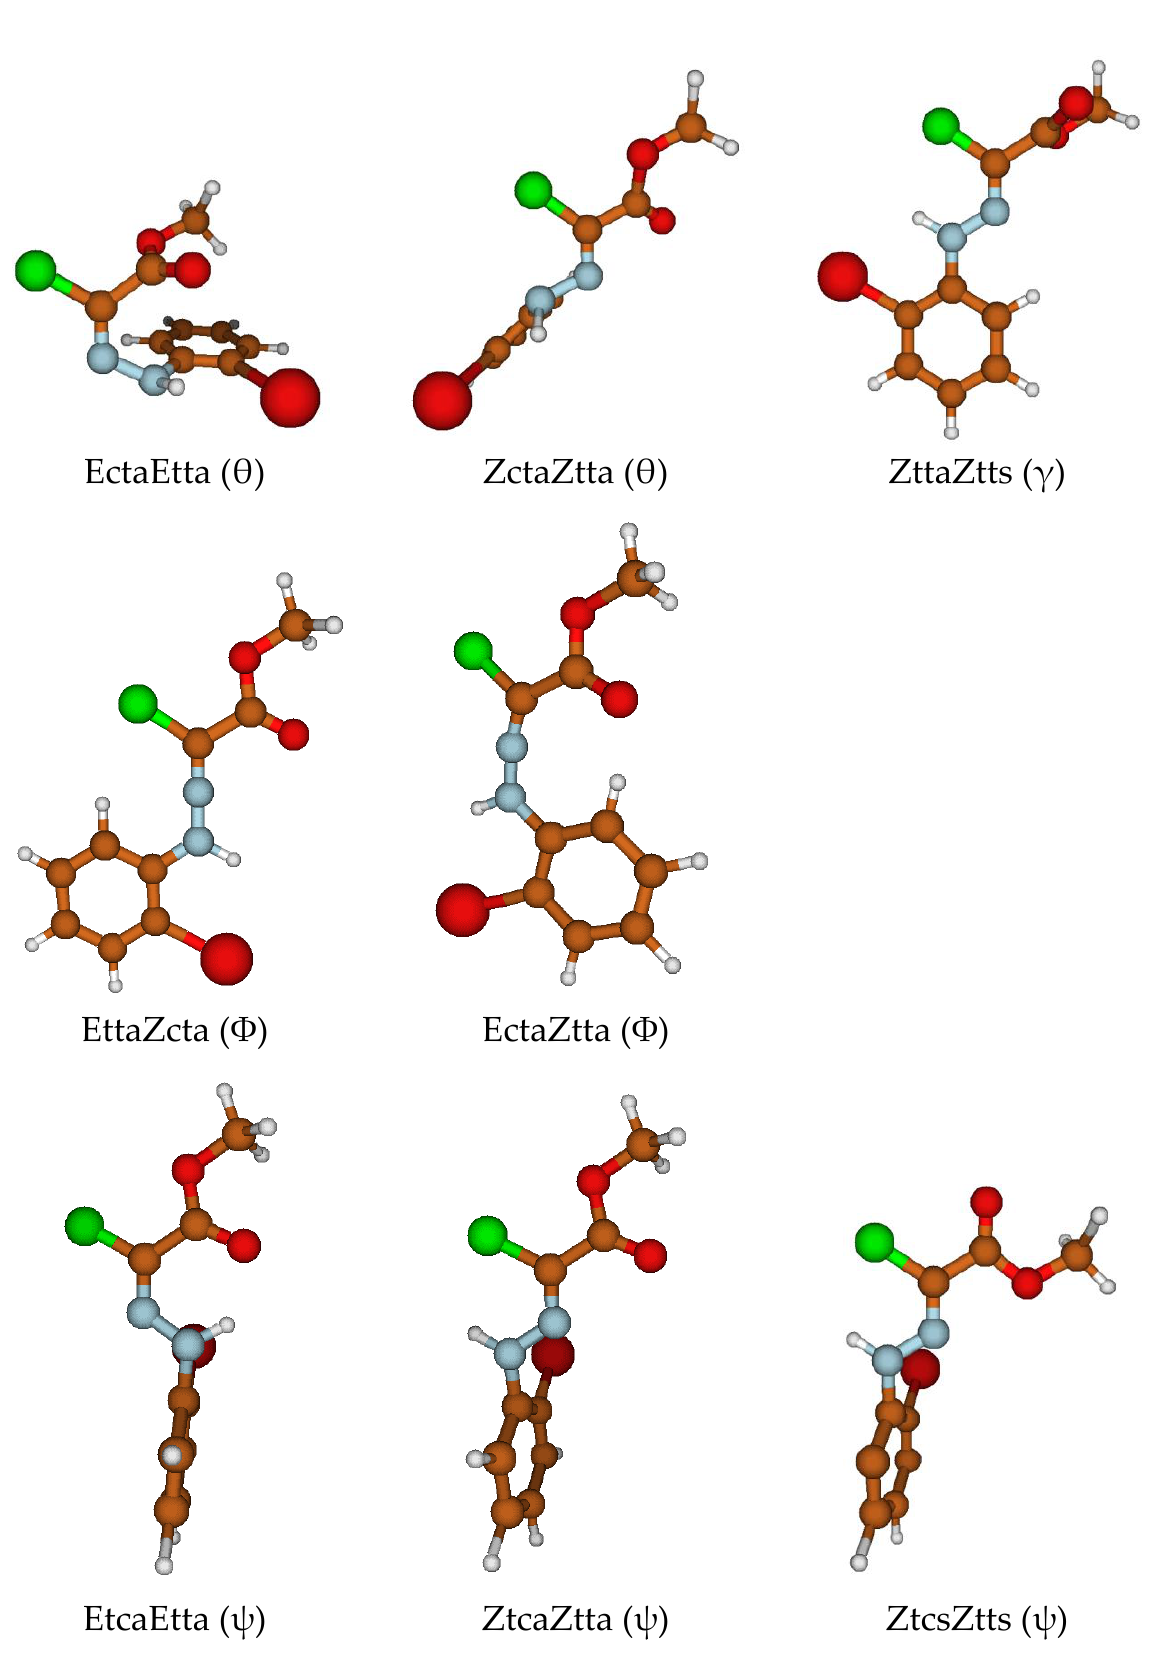
Figure 20. Selected transition state structures of 7 calculated at the ω B97M-D4/cc-pVTZ level. The process type is indicated in parentheses. They are representative of the corresponding transition state structures of 5 and 6 .